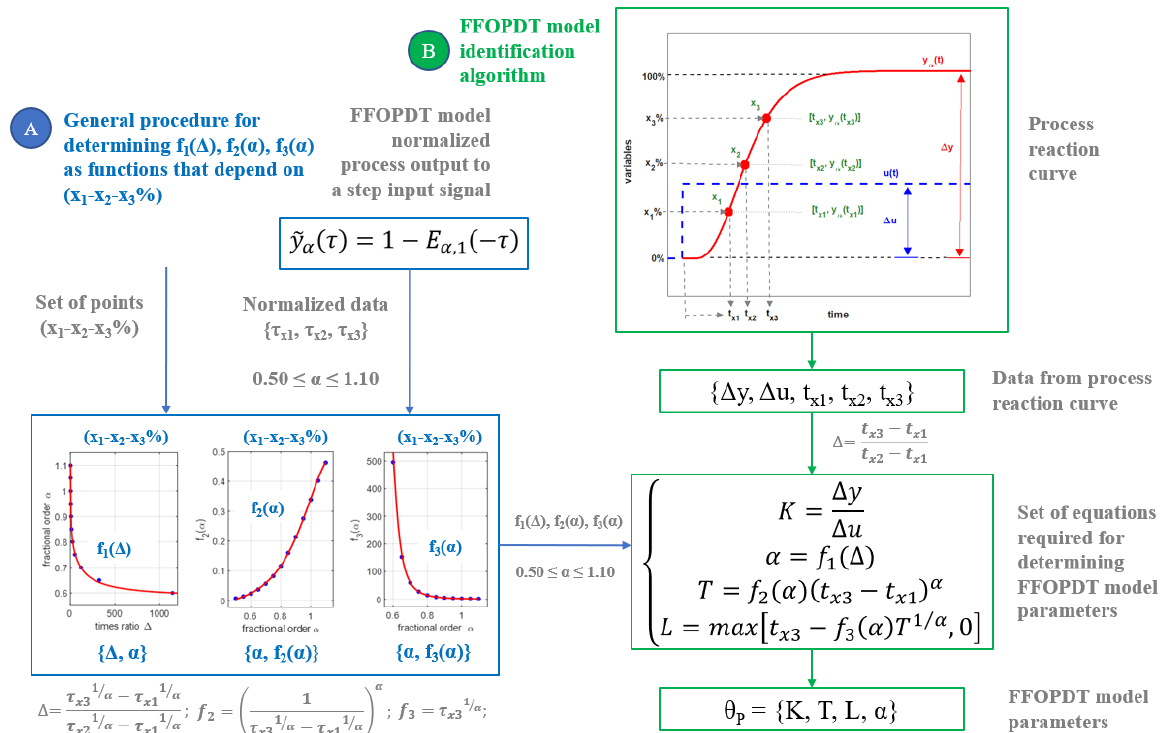
Figure 7. Scheme of the complete procedure for identifying a FFOPDT model considering three arbitrary points (x 1 -x 2 -x 3 %) on the process reaction curve. Note that the scheme is divided into two parts: Part A represents the general procedure to obtain the set of equations for determining FFOPDT model parameters. These equations depend on the set of points (x 1 -x 2 -x 3 %). Part B of the scheme illustrates the FFOPDT model identification algorithm for estimating model parameters θ P = {K, T, L, α } with the information collected from the process reaction curve {Δy, Δu, t x1 , t x2 , t x3 }.